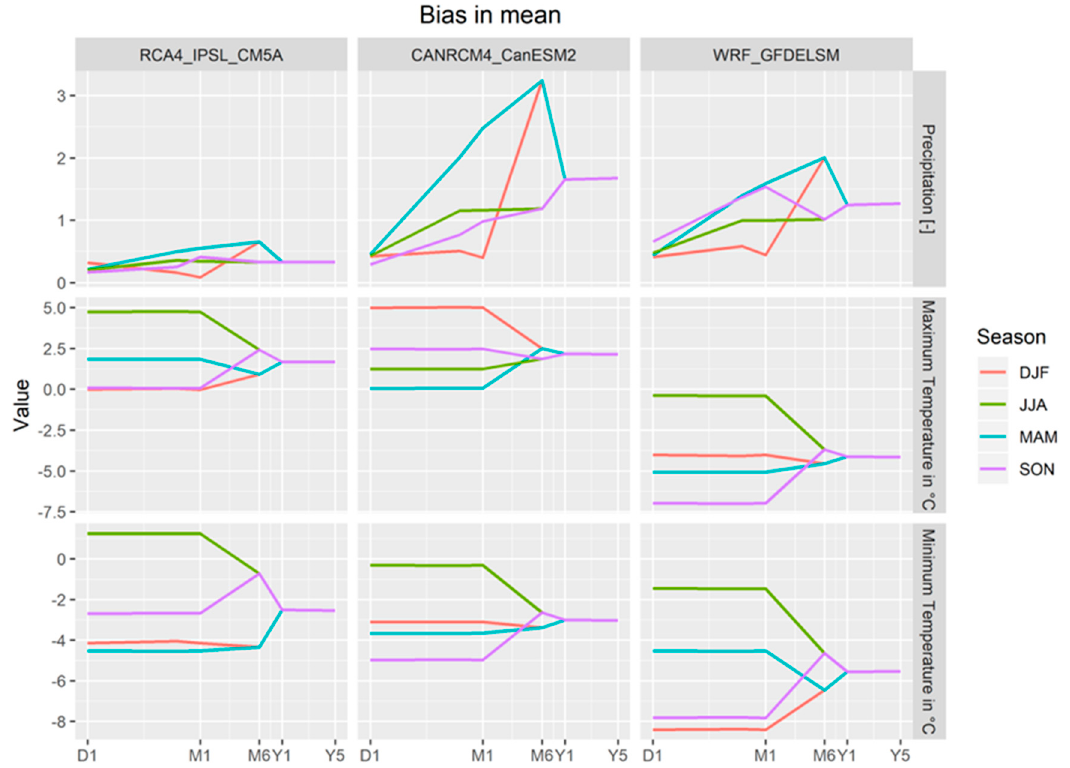
Figure 3. Bias in the mean basin average precipitation and temperature at different timescales between observed and simulated climate model data for the historical period 1980–2005.